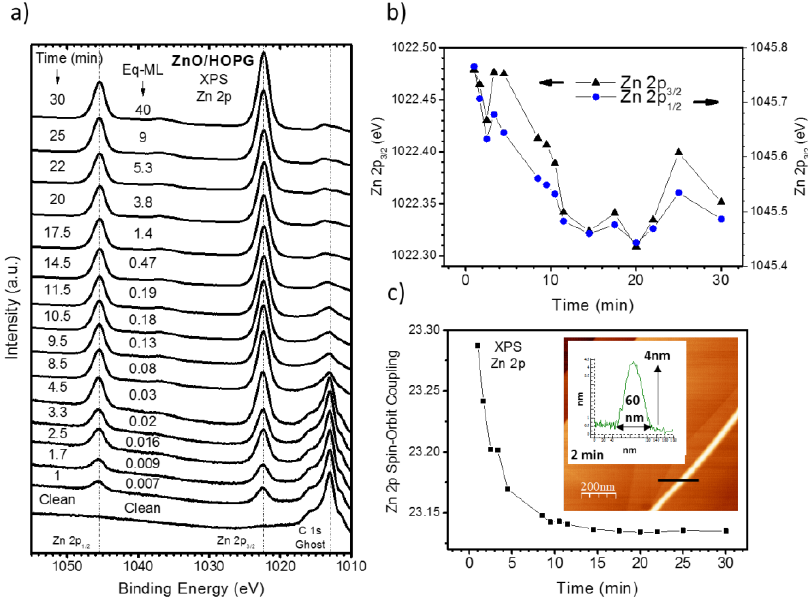
Figure 1. ( a ) XPS Zn 2 p spectra as a function of the coverage and deposition time for the growth of ZnO on highly oriented pyrolytic graphite (HOPG); ( b ) Zn 2 p 3/2 and Zn 2 p 1/2 binding energies as